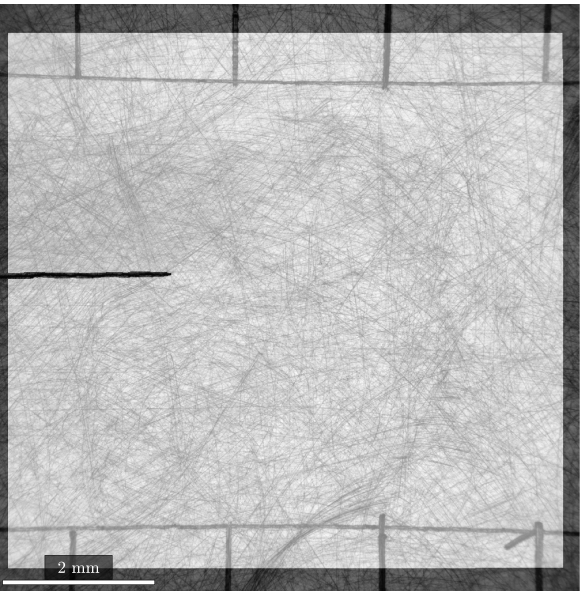
Figure 8. Mask created based on the specimen motion and crack. Lens-induced distortions can be noticed as a curvature of straight judicial lines scratched on the